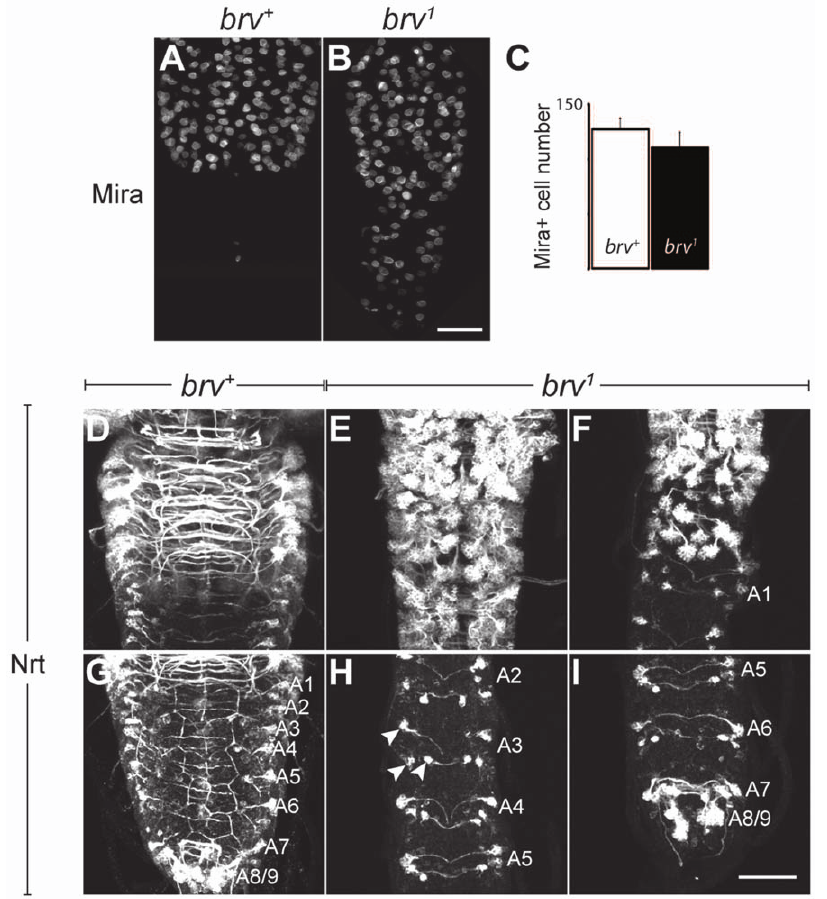
Figure 5. Larval VNC extension is not a consequence of extra larval NB and GMC proliferation. (A–C) Comparison of progenitor cells (neuroblasts and GMCs) in the Antp expressing domain (anti-Antp staining not shown) of (A) brv + and (B) brv 1 mutants using anti-Mira. (C) Quantification of Mira positive cells in brv + and brv 1 . (D–I) anti- Nrt staining in thoracic (D–F) and abdominal neuromeres (G–I) of L3 larva brains in brv + (D, G) and brv 1 mutants (E, F, H,I). A1–A9: abdominal neuromeres 1 to 9. Arrowheads in H point to the 3 Nrt positive NB lineages in A3. A–B and D–I represent maximum projections of Z-stacks. Bar: 20 m m.